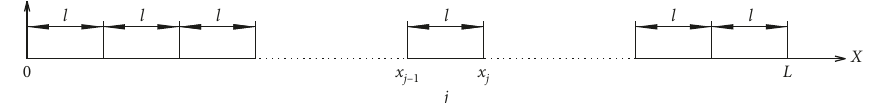
Figure 1: Section diagram of the